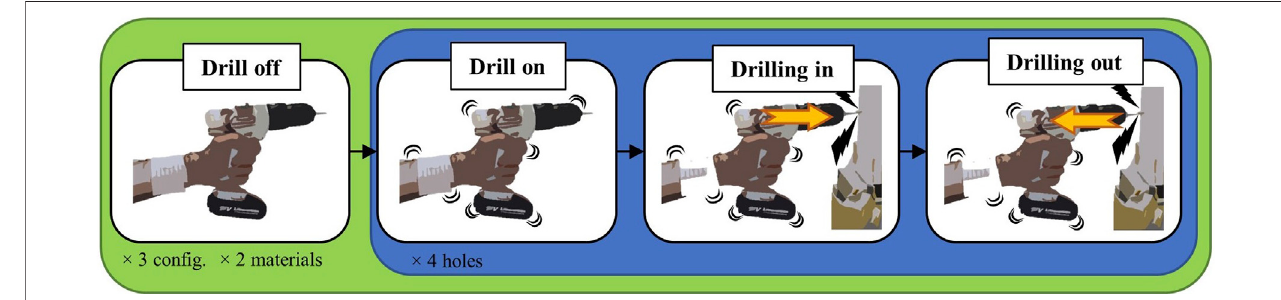
FIGURE 5 | Work fl ow of the different experimental